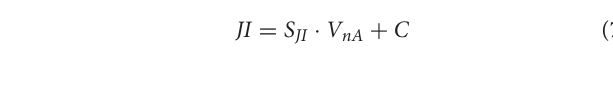
TABLE 2 | Relative volume of aeartion compartments and effective lung volume ( ELV ) as determined using the networks lung ROI predictions u 2 Net 64 and u 2 Net 128 on the experimental data set. Ref. mask